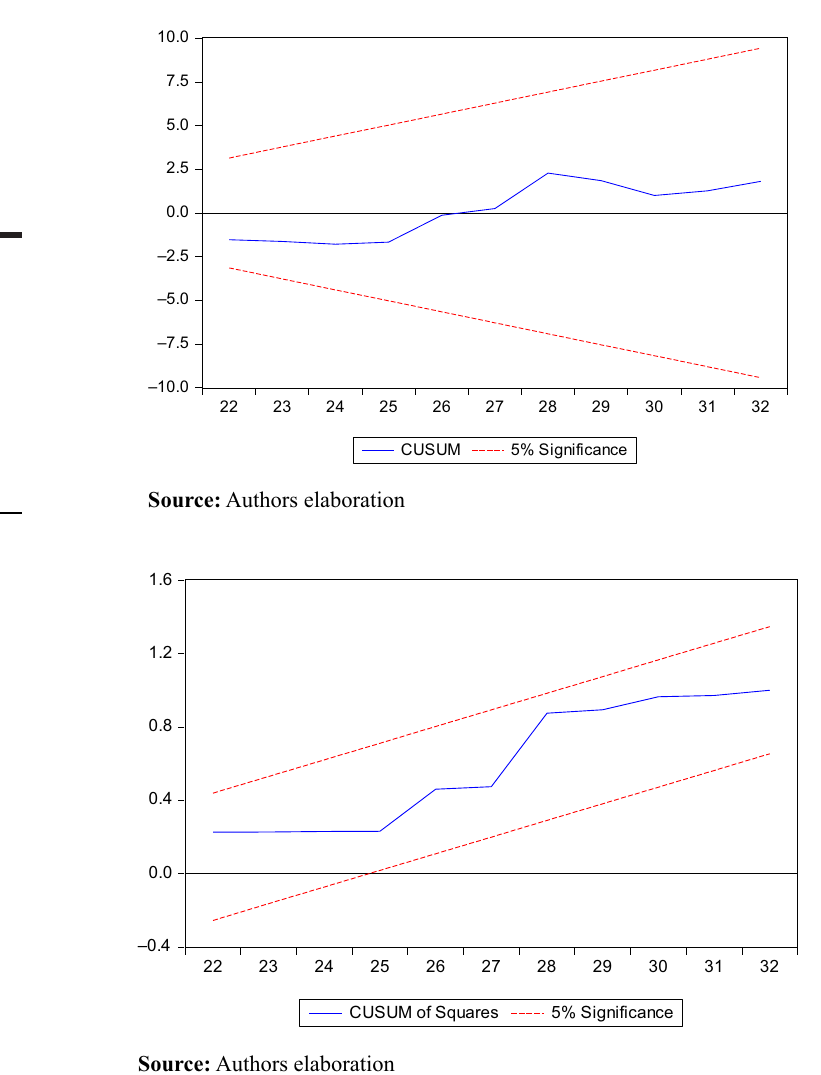
indicated that gold prices have a positive impact on stock market prices of large emerging BRIC economies and a negative impact on the stock markets of Mexico, Malaysia, Thailand, Chile and Indonesia. Oil prices have a negative impact on stock markets of all emerging economies. Gold and oil volatilities have a negative impact on stock markets of all emerging economies in both the short- and the long-run. The results indicated that the stock markets in the emerging economies are more vulnerable to bad news and events that result in uncertain economic conditions.